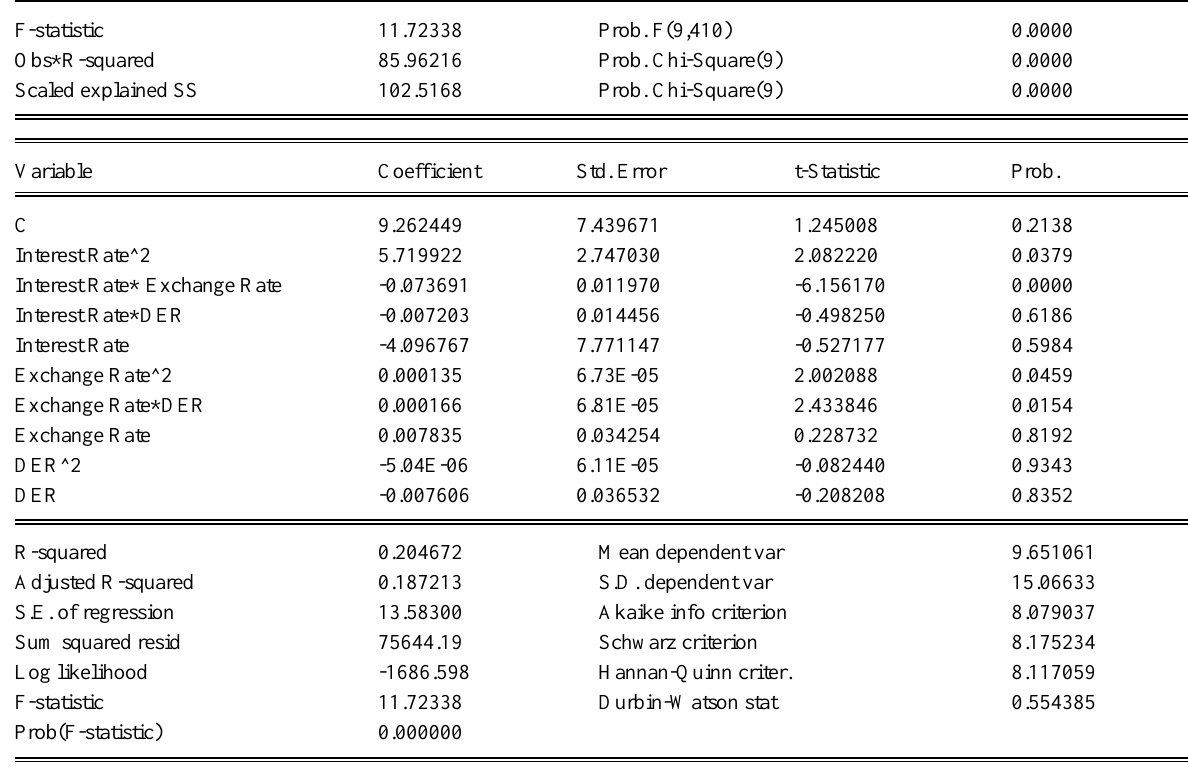
Table 7: Heteroscedasticity